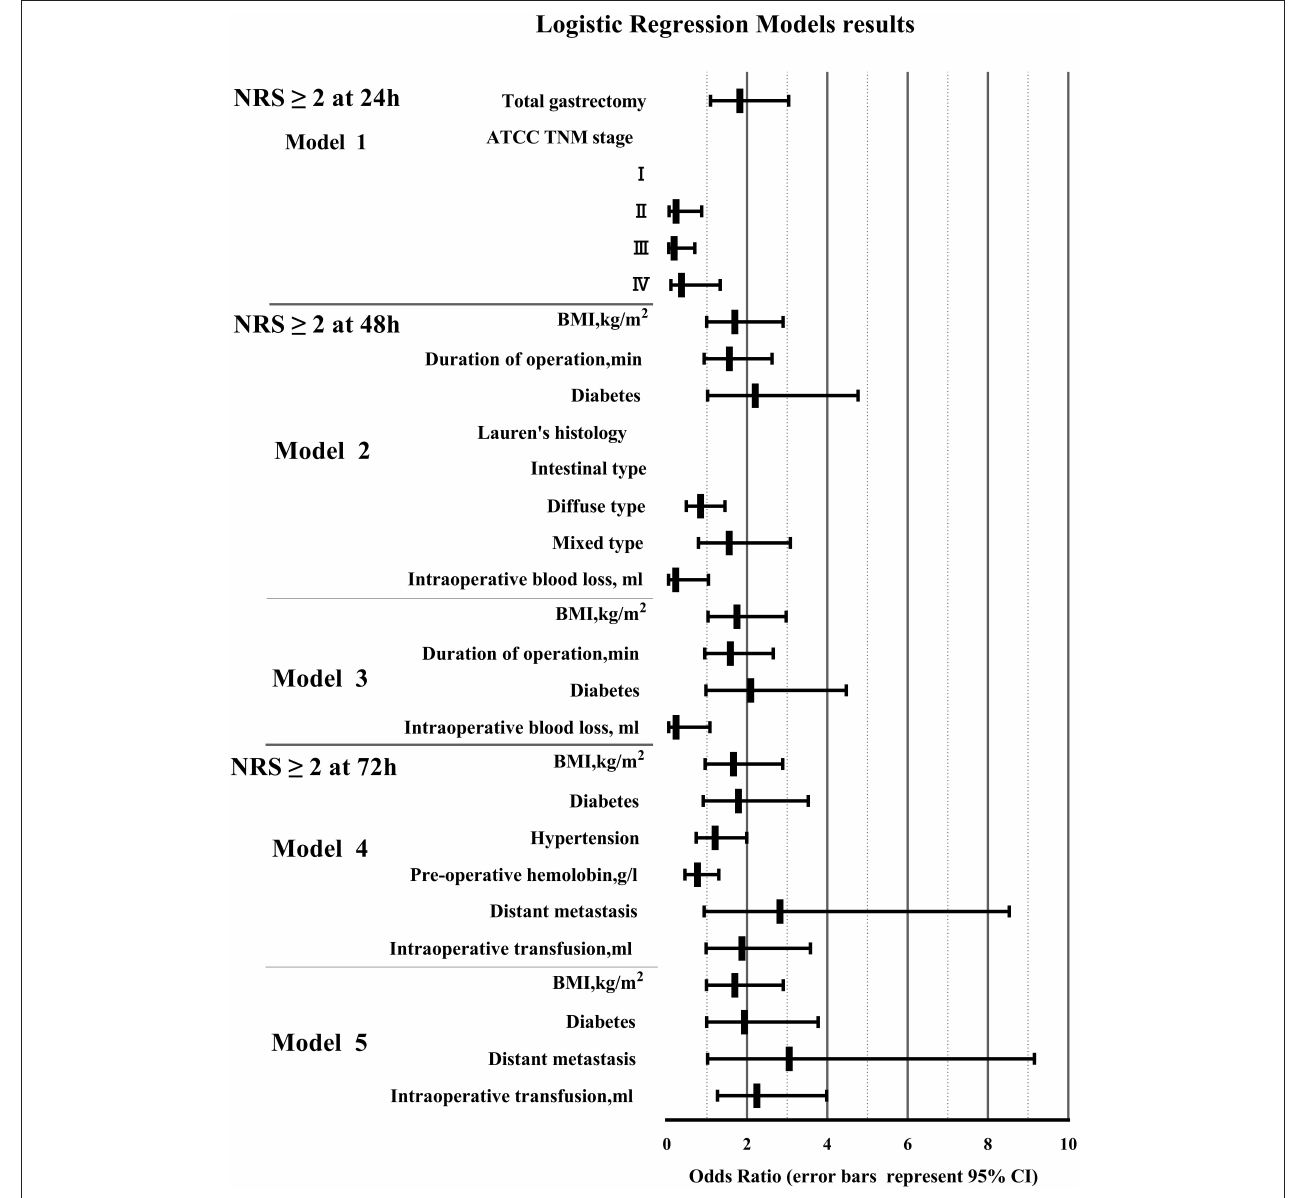
FIGURE 3 | Binary logistic regression model results. (BMI, body mass index; NRS, Numerical Rating Scale; AJCC, American Joint Committee on Cancer; TNM, Tumor Node